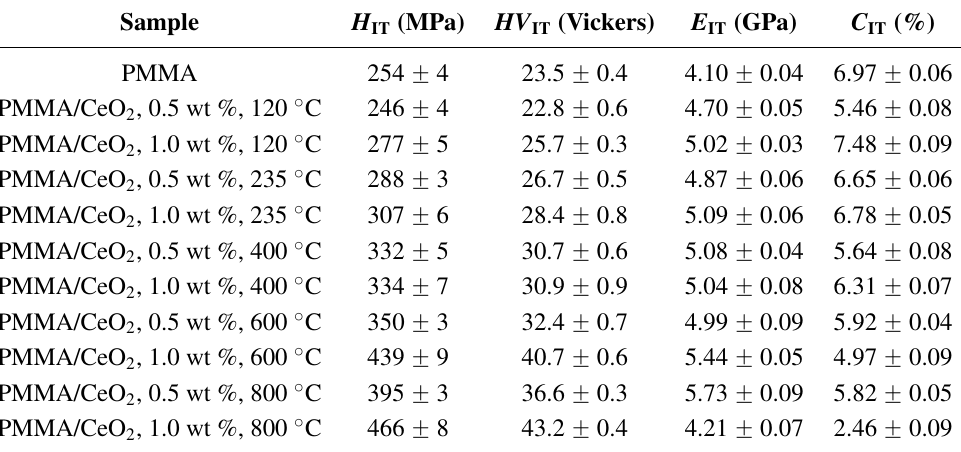
Figure 14. Load-displacement curves of PMMA and PMMA/CeO 2 hybrid systems. Table 3. Hardness ( H IT ), Vickers hardness ( HV IT ), elastic modulus ( E IT ) and creep ( C IT ) values for pure PMMA and PMMA/CeO 2 hybrid systems.